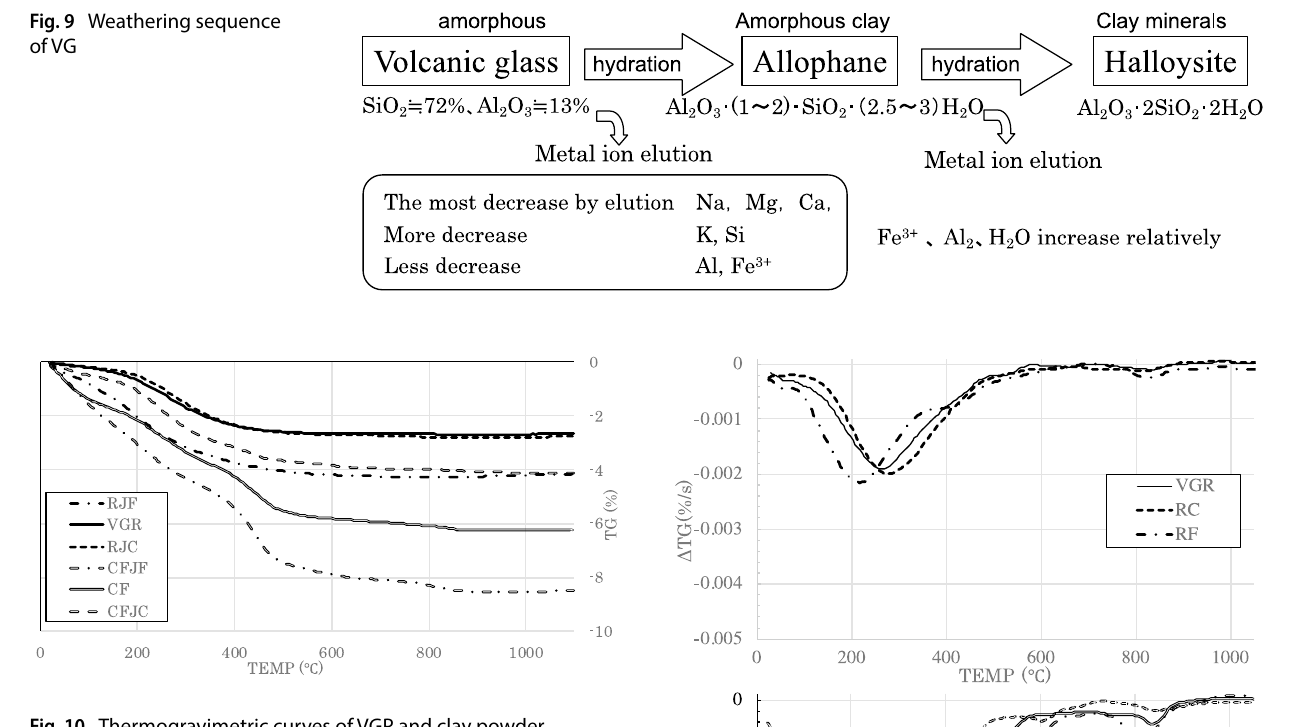
Fig. 10 Thermogravimetric curves of VGP and clay powder